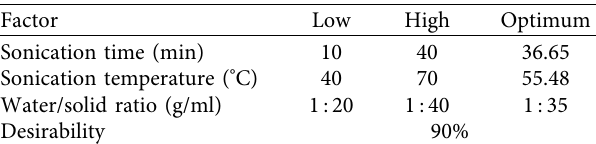
Table 2: Predicted optimum condition for ultrasound-assisted extraction of inulin from the burdock